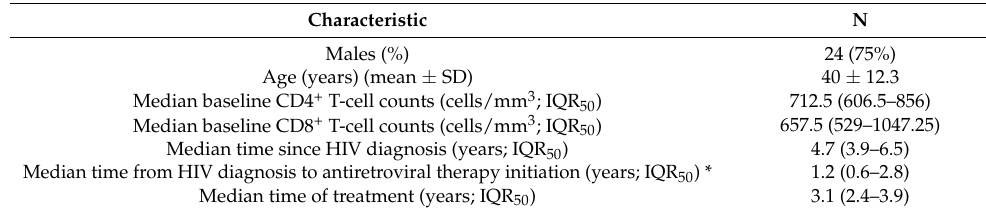
Table 2. Demographic and clinical characteristics of the 32 human immunodeficiency virus (HIV)-positive participants of the